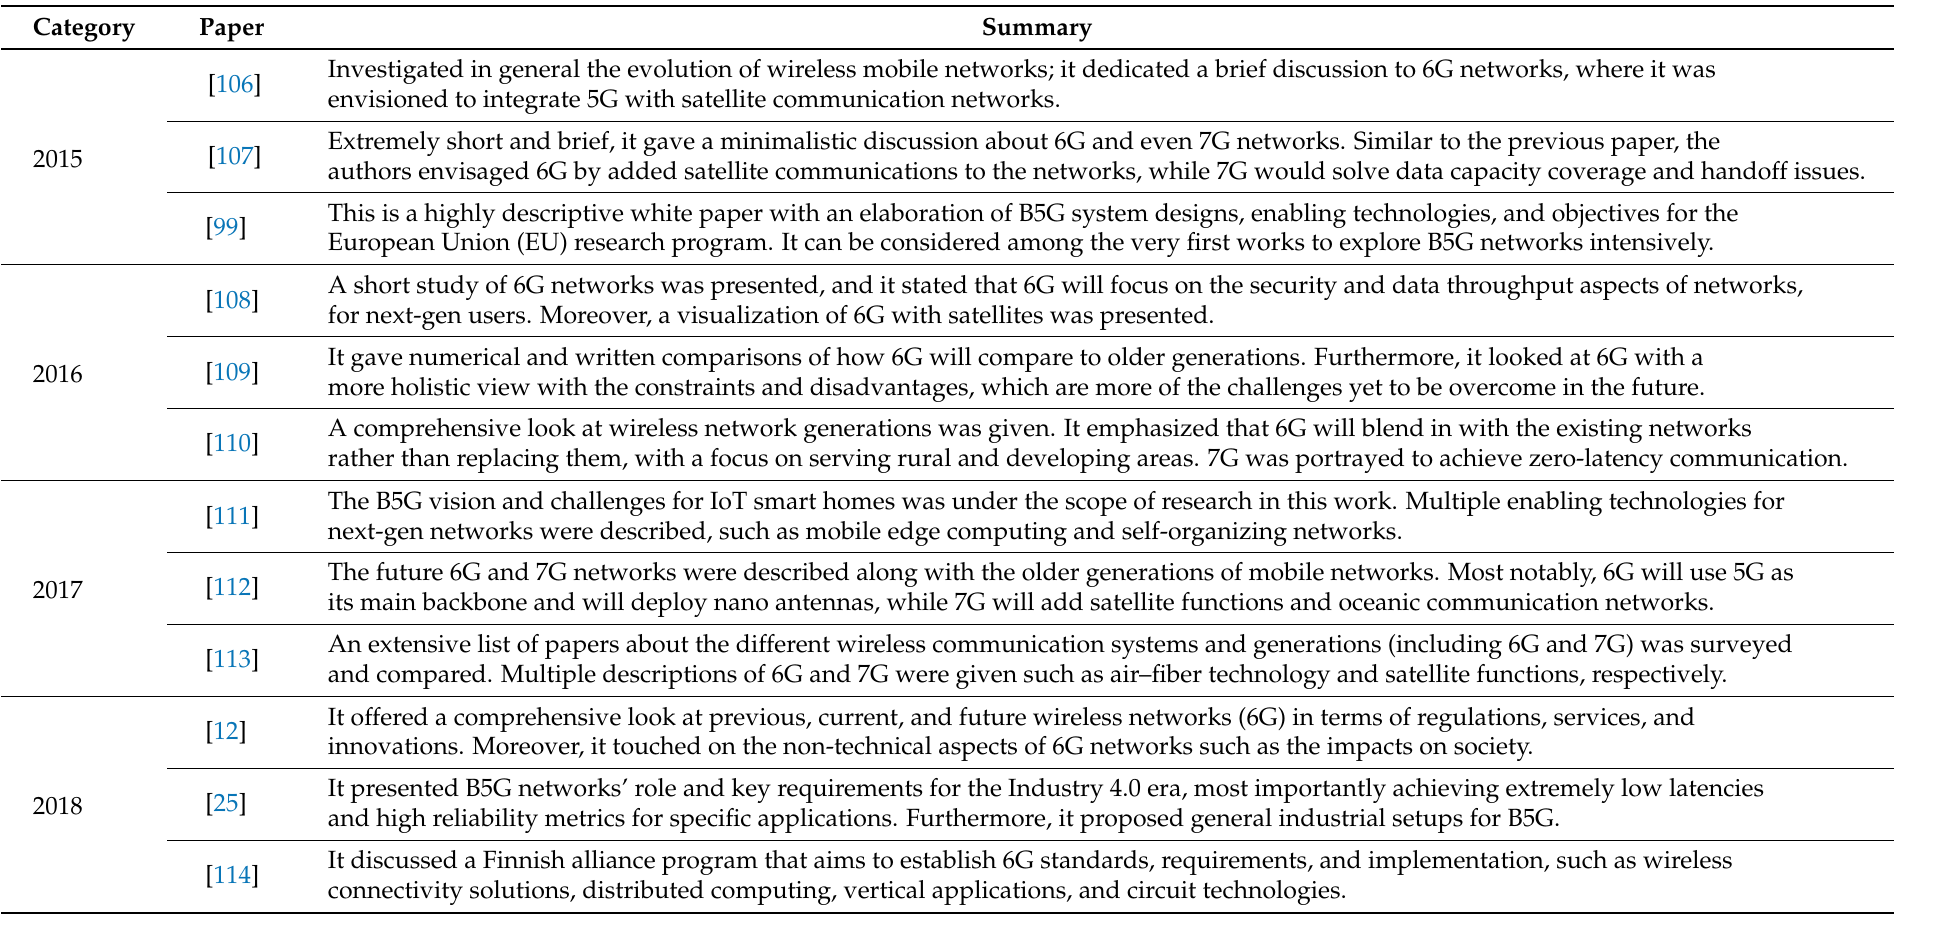
Table 2. A short overview of the main papers published in the last 5 years on B5G and/or 6G